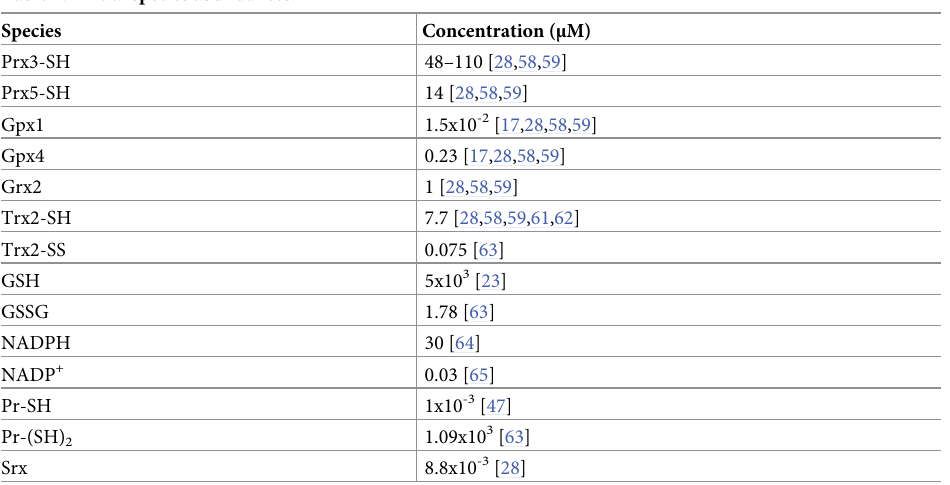
Table 2. Initial species abundances.